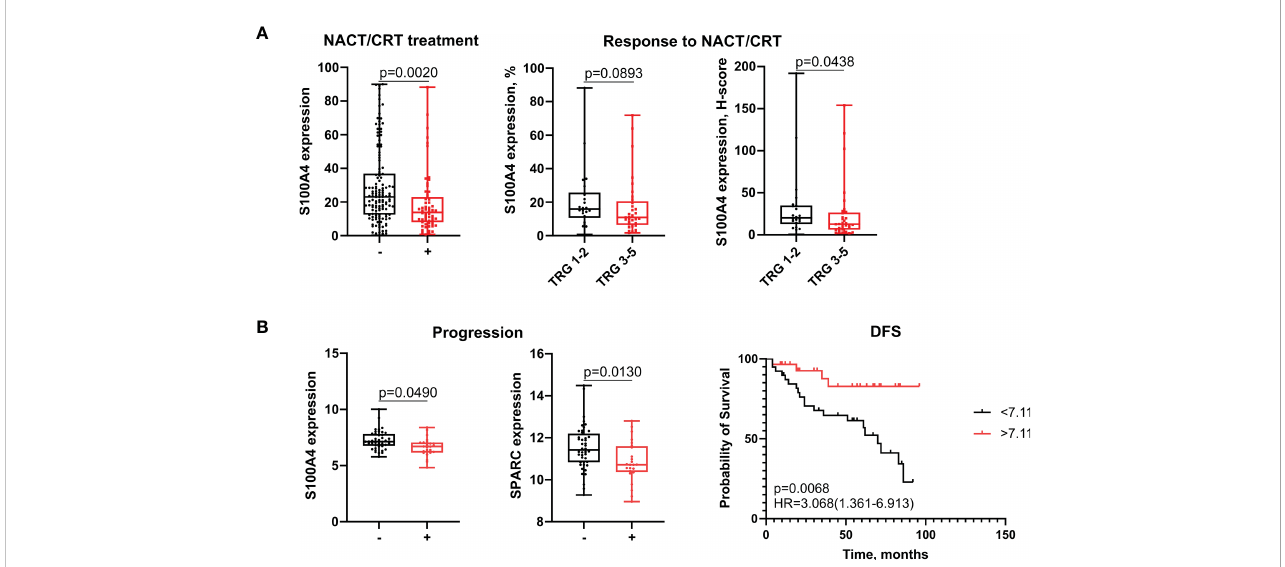
FIGURE 6 S100A4 is associated with improved outcomes in patients undergone neoadjuvant chemotherapy-based treatment. (A) Stromal expression of S100A4 decreased in treated patients and correlated with favorable response to NACT/CRT. (B) S100A4 and SPARC mRNA expression decreased in non- responders with progression. S100A4 high-risk score predicts better DFS. Mann-Whitney U test was applied. Box plots depict protein (A) and gene (B) expression (min, Q1, median, Q3, max). Log-rank test p-value is shown in Kaplan-Meier